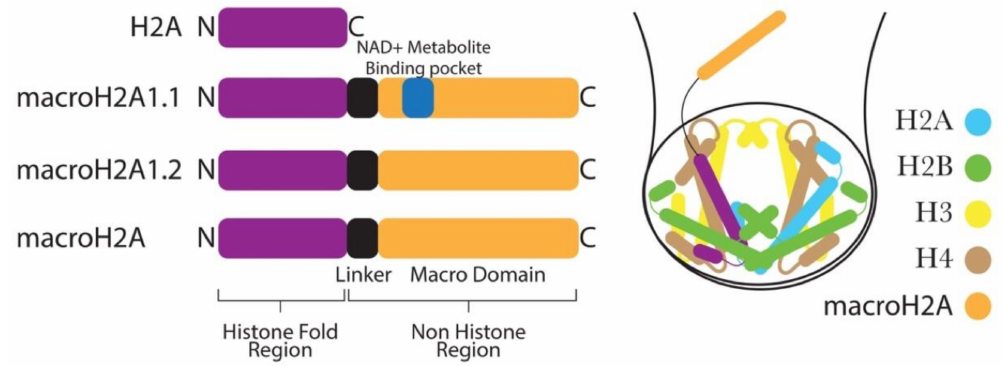
Figure 3. MacroH2A histone variants have a characteristic C-terminal nonhistone domain and a linker region. The nonhistone domain protrudes out from the nucleosome